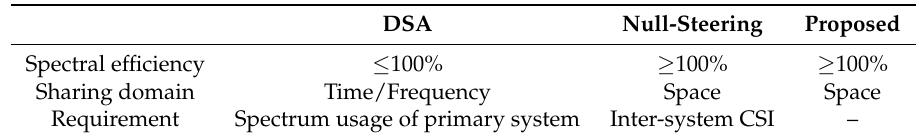
Table 1. Comparisons in spectrum sharing/superposing approaches. DSA: dynamic spectrum access, CSI: channel state